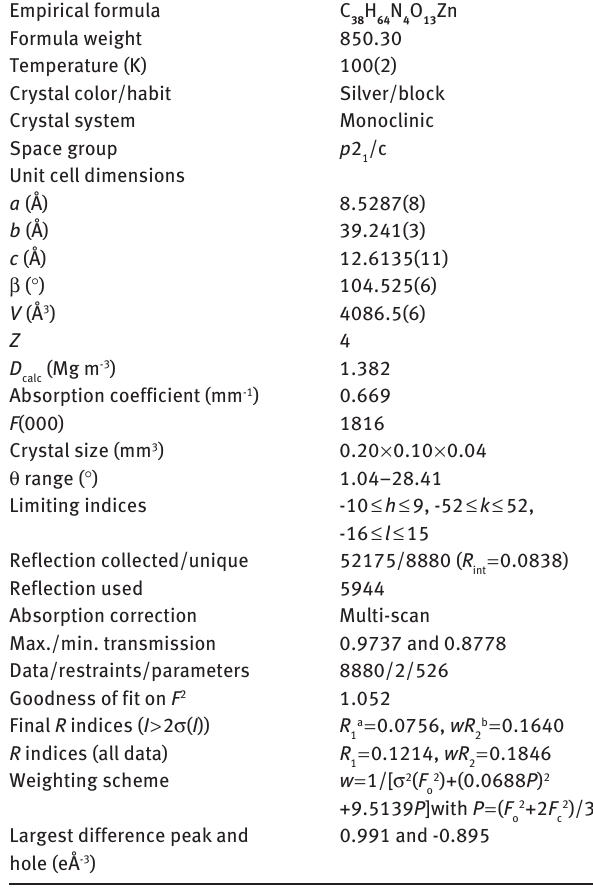
Table 3: Crystallographic data for [Zn(L)(H Empirical